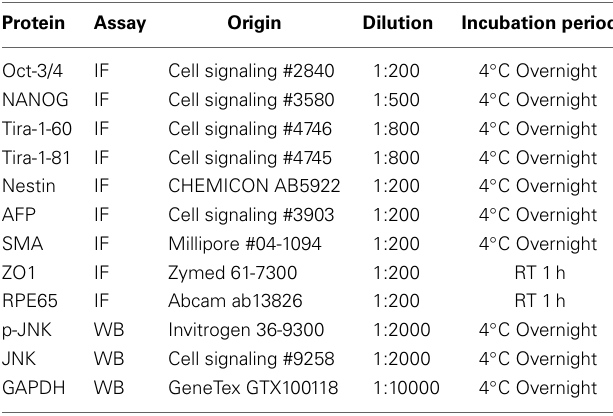
Table 2 | List of proteins tested by antibodies.